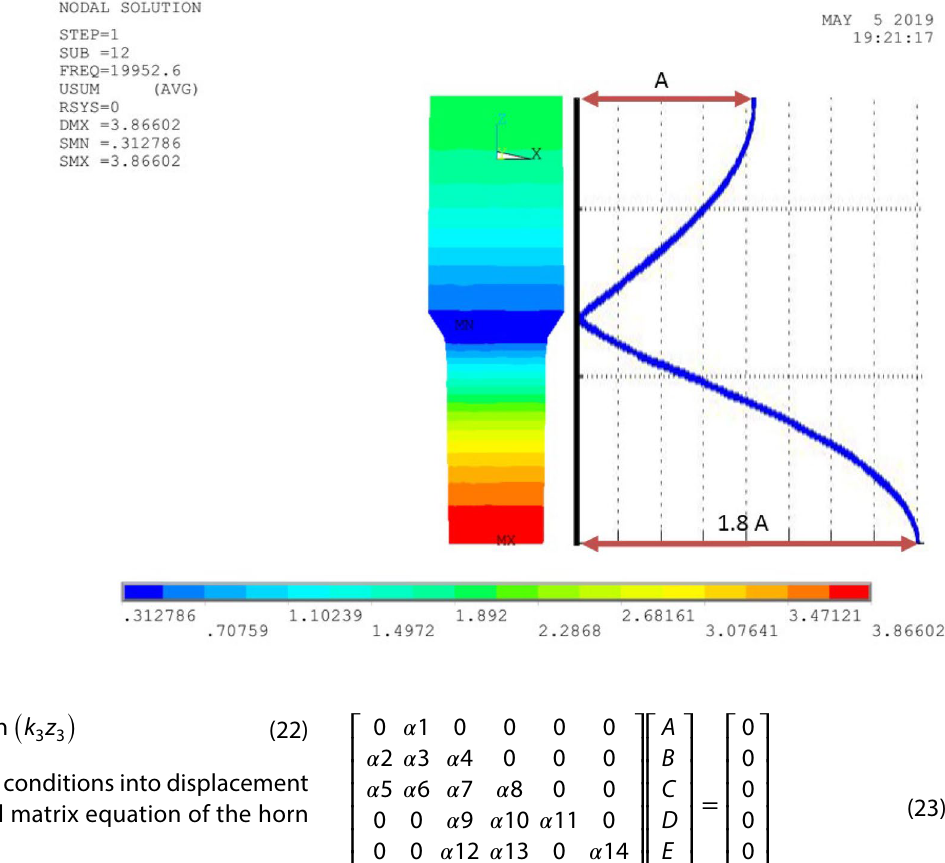
Fig. 8 Horn’s mode shape of the first longitudinal resonance frequency of 19,952.6